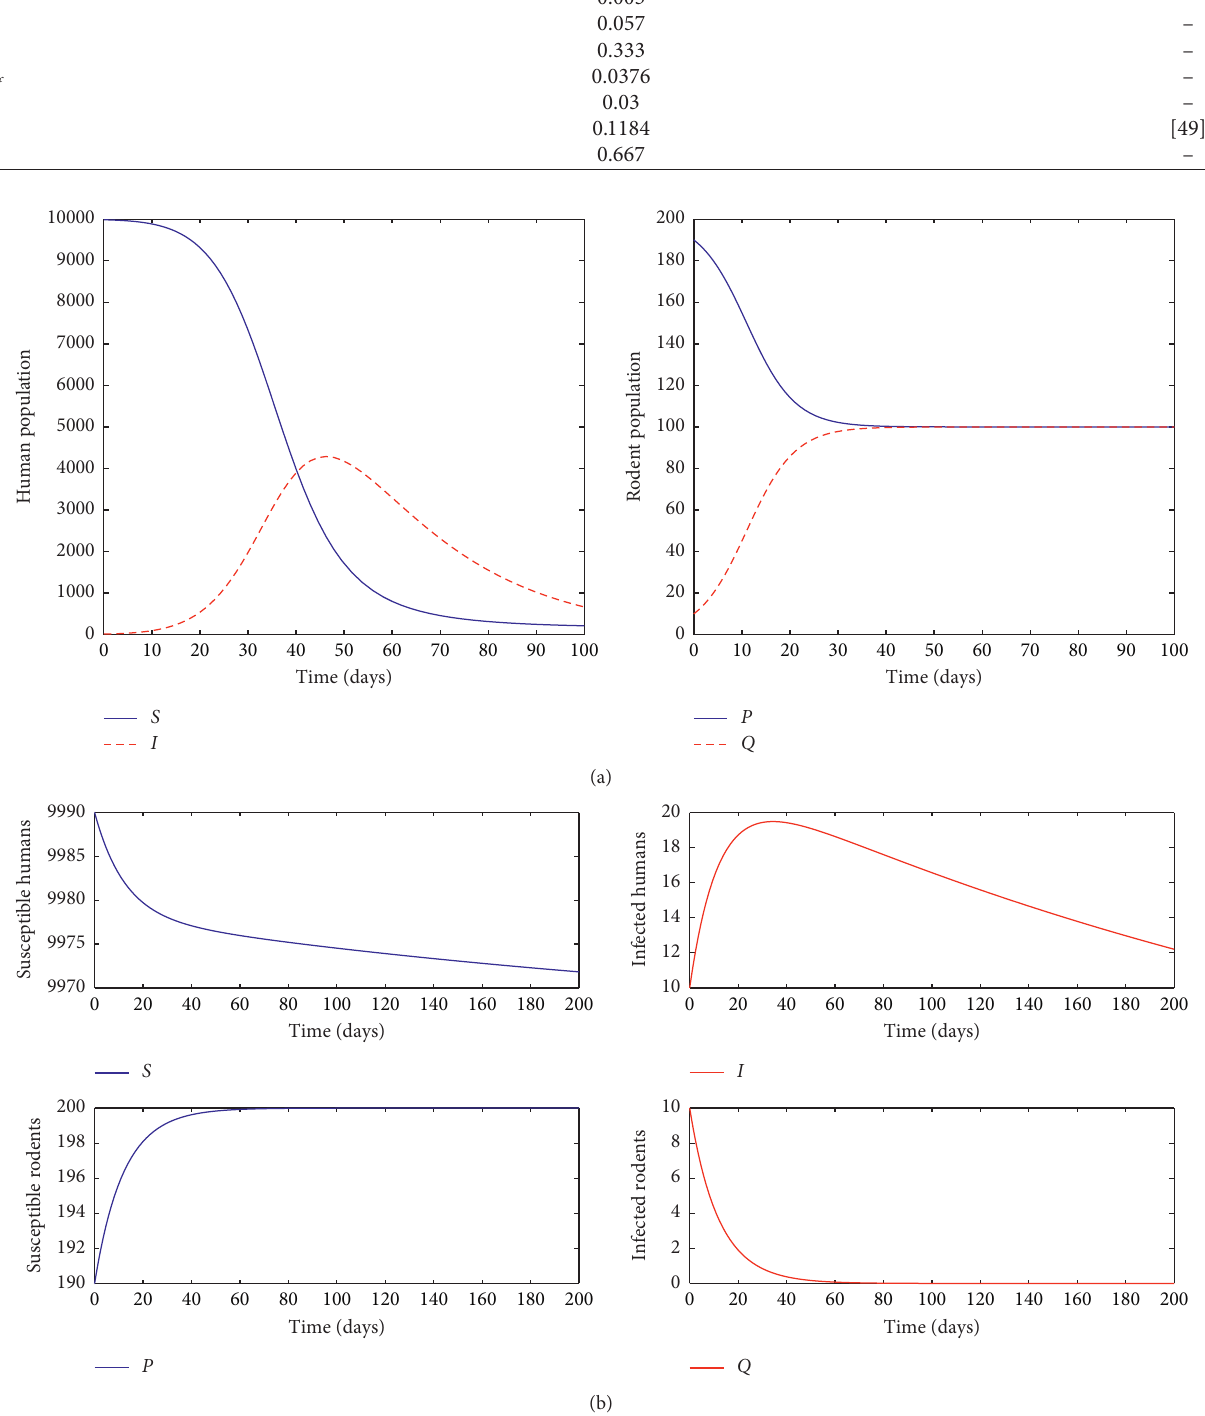
Figure 1: Graphical illustration of possible dynamics of model (1) for R � 2 . 0000; (b) R � 0 . 3957 and R � 0 . 6000. R r h r